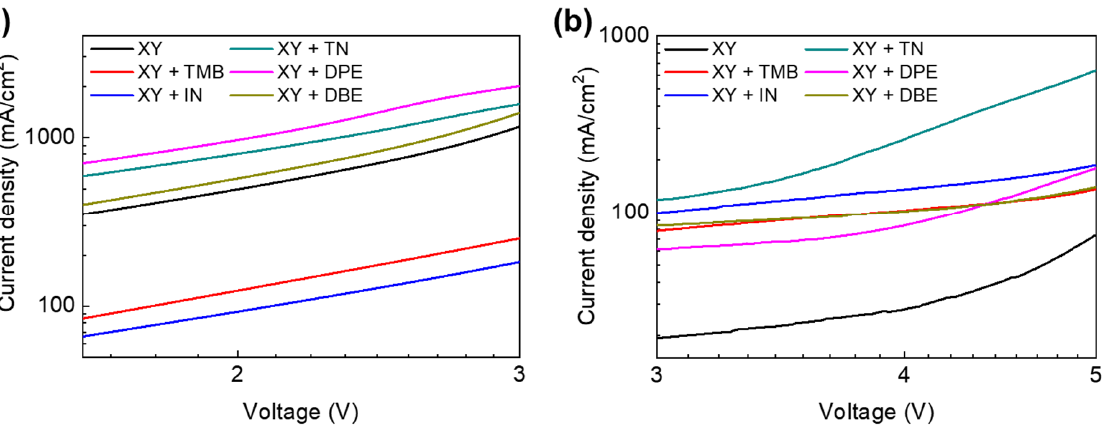
Figure 10. J − V characteristics of the SCLC regime of ( a ) hole ‐ only devices and ( b ) electron ‐ only devices. Table 3. Summary of hole mobility ( μ h ) , electron mobility ( μ e ), and the ratio of hole and electron mobilities ( μ h / μ e ) of XY ‐ and XY + additive ‐ based APSCs .